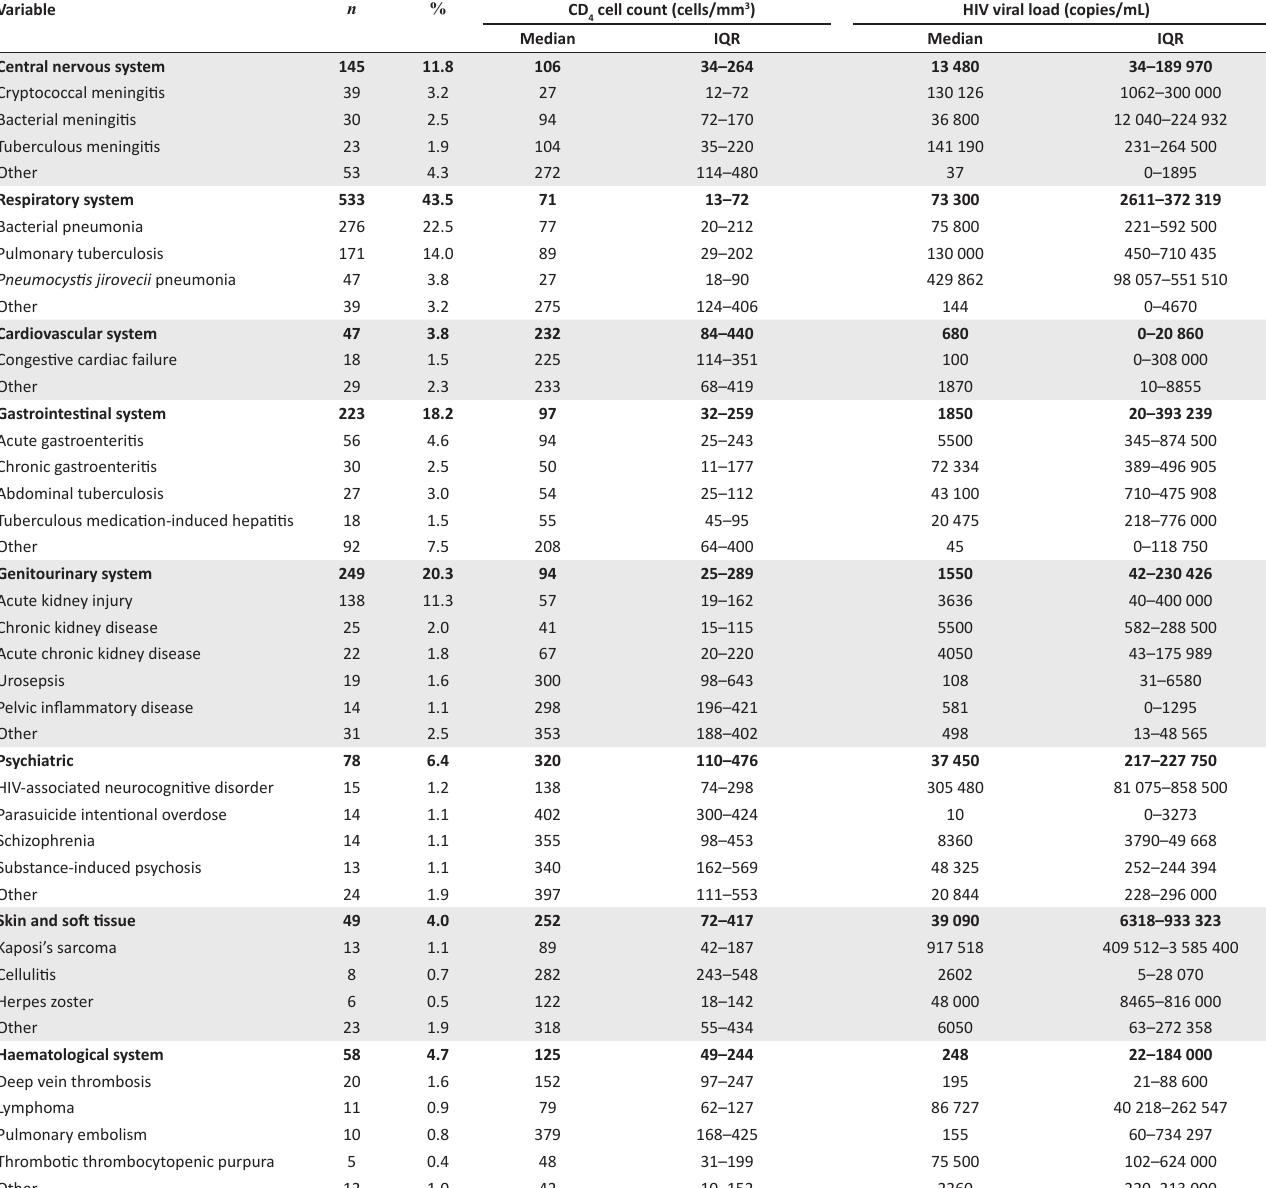
cell count and human immunodeficiency virus viral load amongst study participants. 4